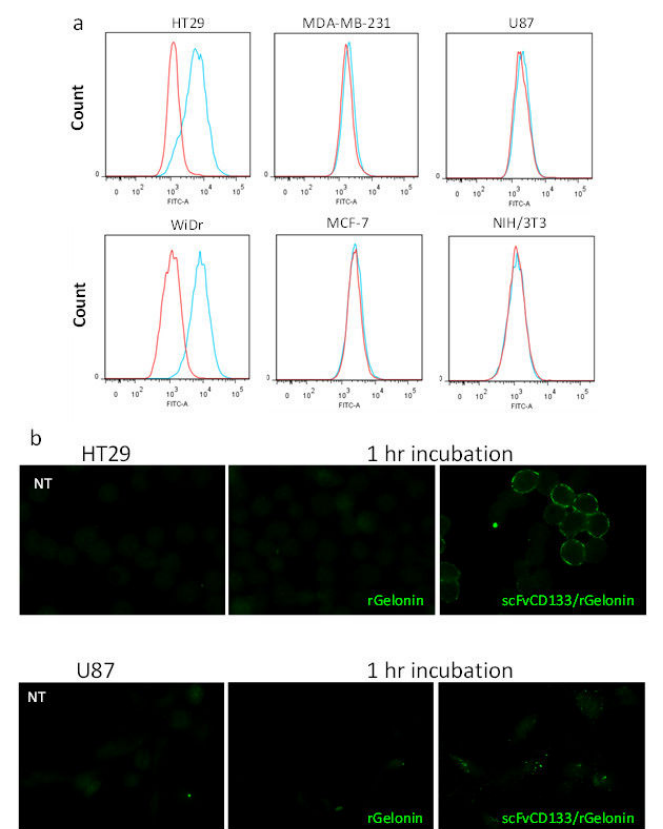
Figure 2. Characterization of CD133 plasmamembrane expression and binding / internalization of scFvCD133 / rGel. ( a ) Detection of CD133 expression in live cells assessed by flow cytometry after 1 h. ice-cold incubation of the mouse primary antibody anti-CD133 (HB#7, which have the same binding site on the CD133 receptor as the scFV-fragment of the scFvCD133 / rGel immunotoxin) and a secondary anti mouse-FITC antibody. The result is representative from three individual experiments, and in addition to three other experiments performed in methanol fixed cells. ( b ) Fluorescence microscopy 1 h. after incubation at 37 ◦ C with either 10 nM rGelonin or scFvCD133 / rGelonin in HT29 and U87 cells (as indicated in the panels). Cells were fixed with methanol, and both toxin (rGel) and immunotoxin (scFvCD133 / rGel) was detected by a polyclonal anti-rGelonin antibody and a secondary anti-rabbit mAb-Alexa488. The micrograph is a representative result from three individual